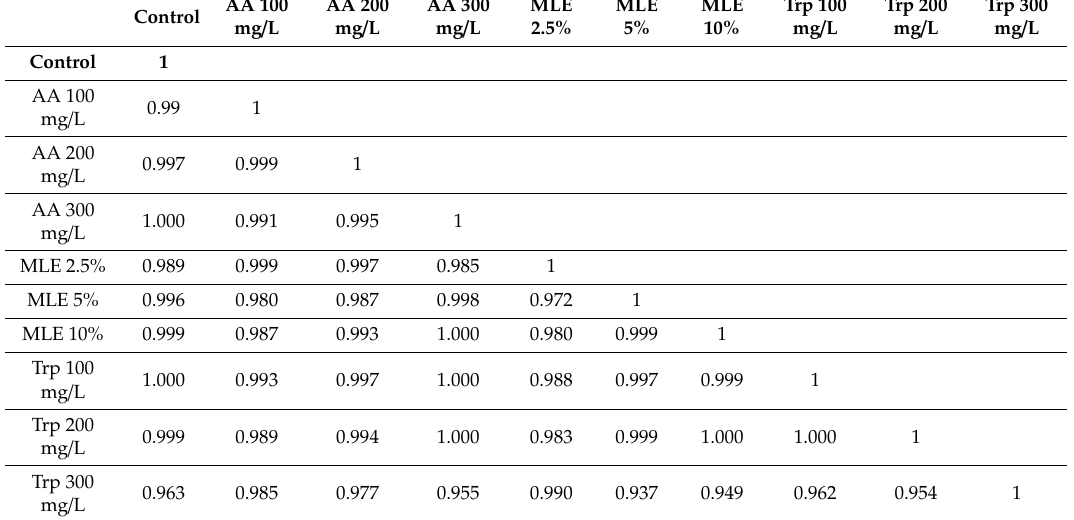
Table 4. Correction coe ffi cient (r) among the treatments a ff ecting the monoterpenoids and sesquiterpenoids or oxygenated and non-oxygenated constituents of the essential